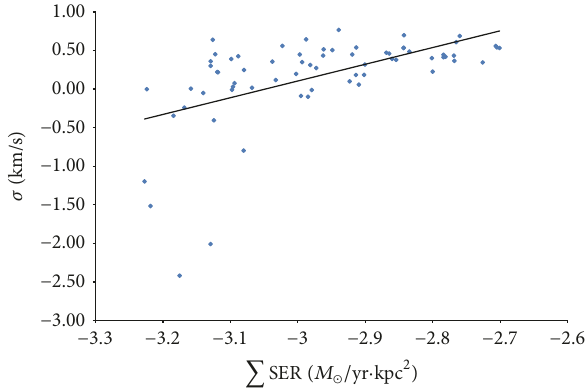
Figure 5: The velocity dispersion for each pixel 𝜎 of Centaurus A as a function of the SFR surface averaged (in units of 𝑀 ⊙ /yr ⋅ kpc 2 ).